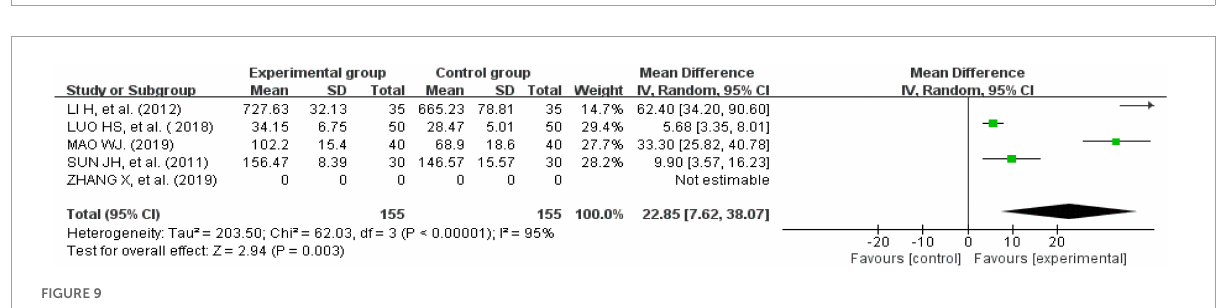
FIGURE9 Forest plot of the score on Irritable bowel syndrome-quality of life